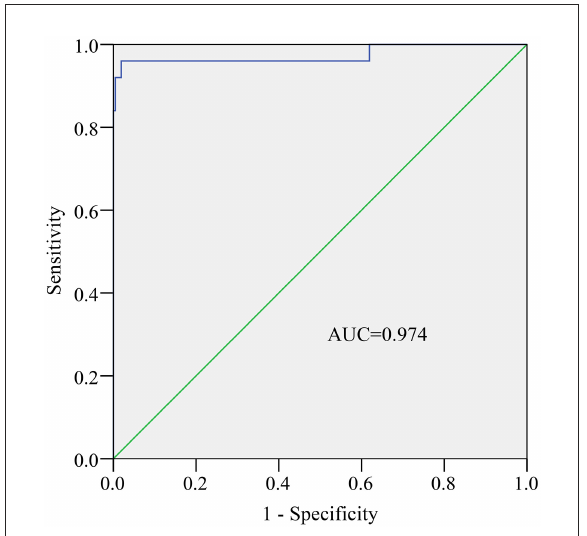
FIGURE4 Receiver operating characteristic (ROC) curve of AlphaLISA. AUC, area under the curve.